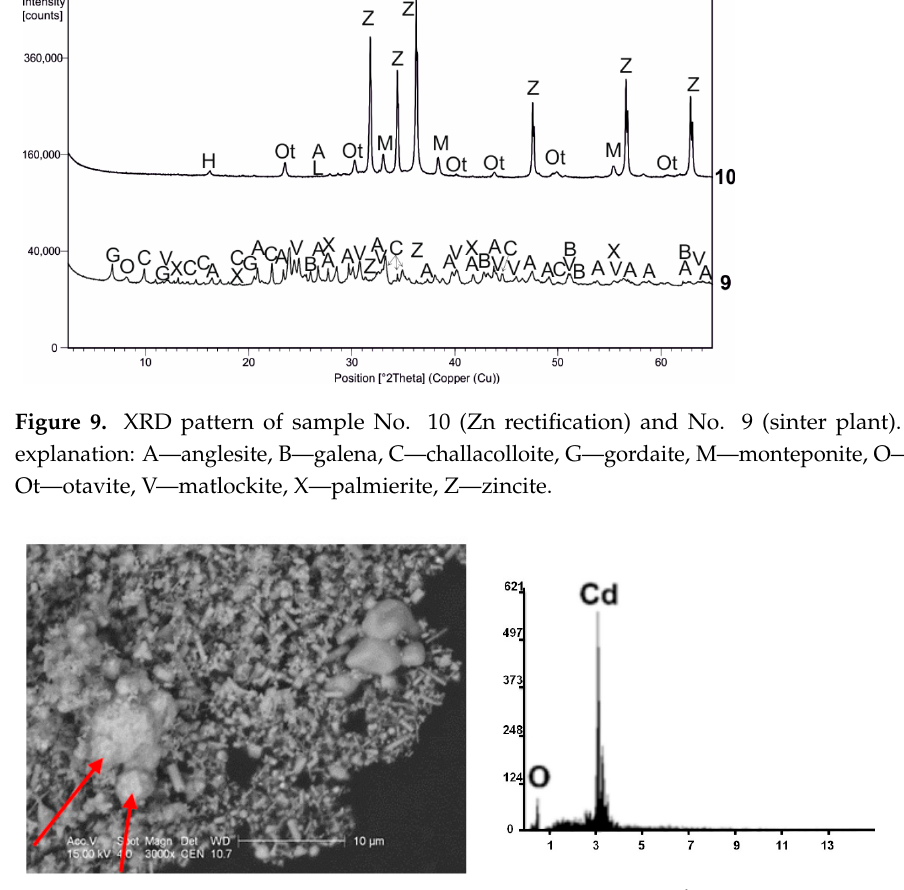
Figure 8. Dust from the Zn rectification process (sample No. 10): ( a , c ) SEM images: red arrow indicates zincite crystals forming twins; yellow arrows—single zincite crystals in the form of a column, sometimes with pyramidal ends; green arrow—twinning of columnar zincite crystals with pyramidal ends; blue arrow—hexagonal crystal of zincite; ( b , d ) the EDS spectrum.